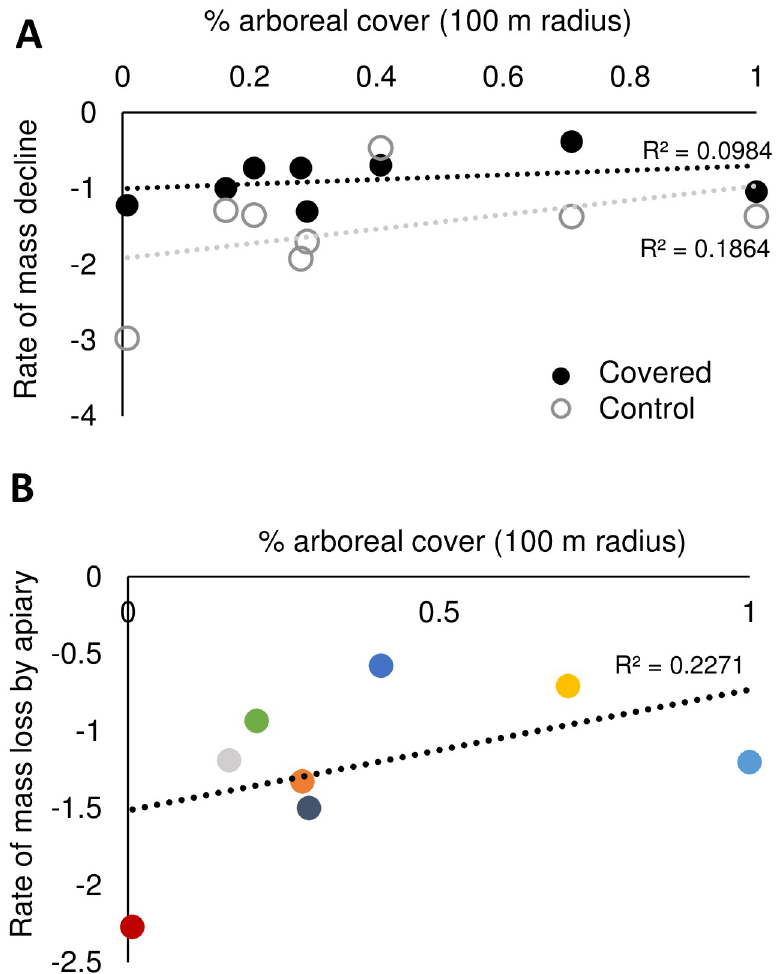
Fig 5. Relationship between the rate of mass decline in (A) covered (solid circles) and control (open circles) colonies and (B) colonies at the apiary level with the proportion of arboreal tree cover within 100 m of apiaries.